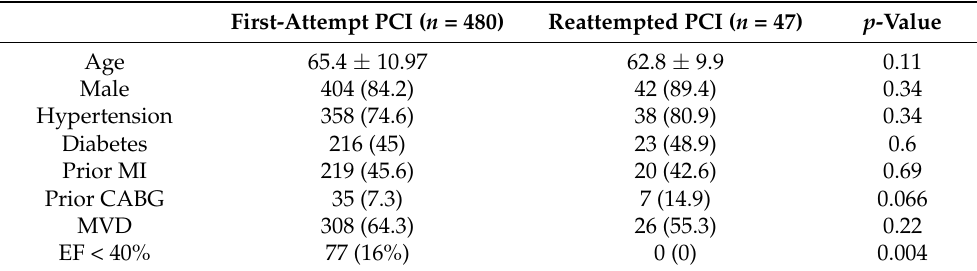
Table 1. Basal and demographic characteristics comparison of first-attempt and reattempted CTO-PCI in the study